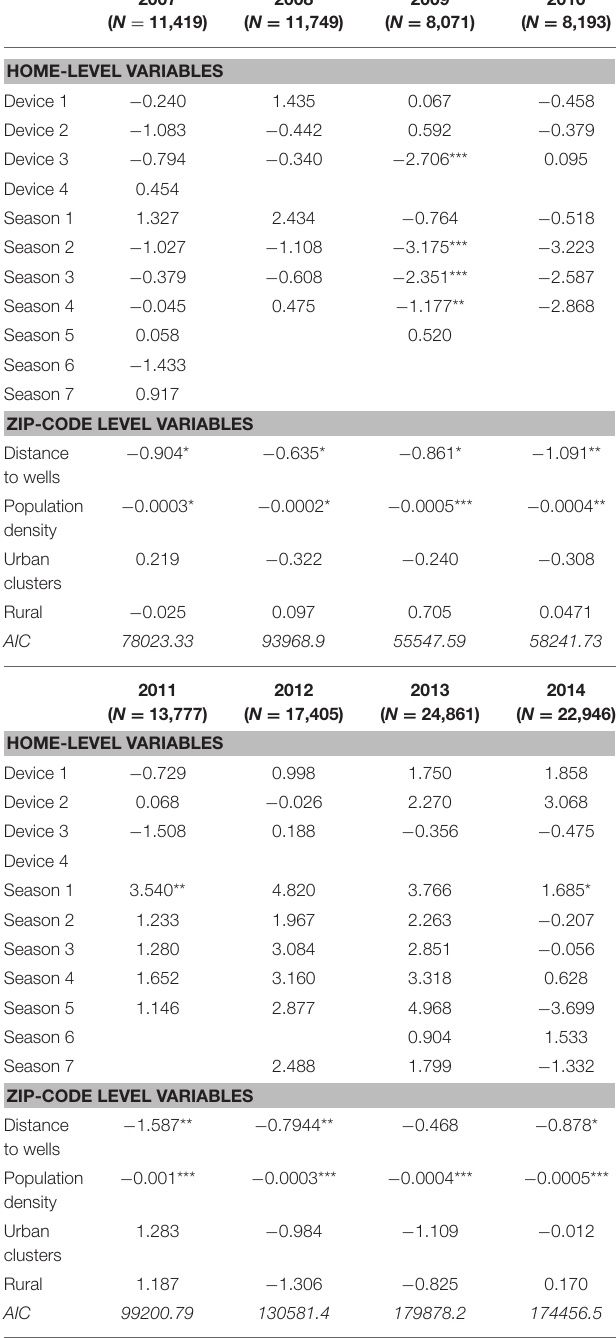
statistical significance. Nearest distances calculated for the year 2008 and 2007 demonstrate that there is a weak correlation between fracking and indoor radon levels. Population density also shows slightly significance of the effects of radon level. Urban clusters and rural clusters do not show any significant differences compared to urbanized areas for all models for individual